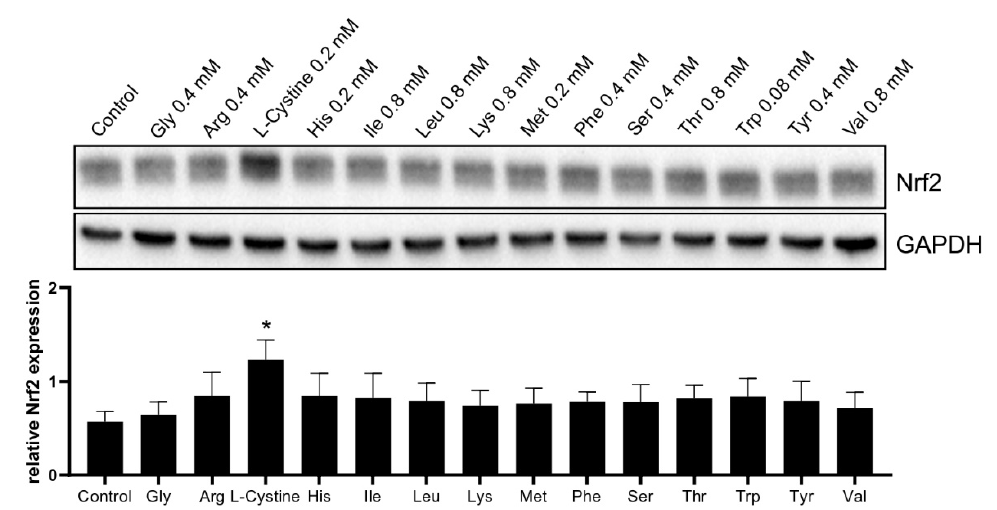
Figure 2. L-Cystine Induces Nrf2 Protein Elevation. The amino acid at its corresponding concentration in DMEM was added to HeLa cells at 3 days after subculture for 4 h of incubation, before harvesting for measuring Nrf2 protein levels by the Western Blot, using GAPDH as a loading control. The band intensities were quantified by NIH ImageJ to be presented as means ± SD of Nrf2/GAPDH ratio from three independent experiments. * indicates statistically significant as the adjusted p value < 0.05 compared to the control by one-way ANOVA, corrected by Dunnett’s multiple comparisons test.